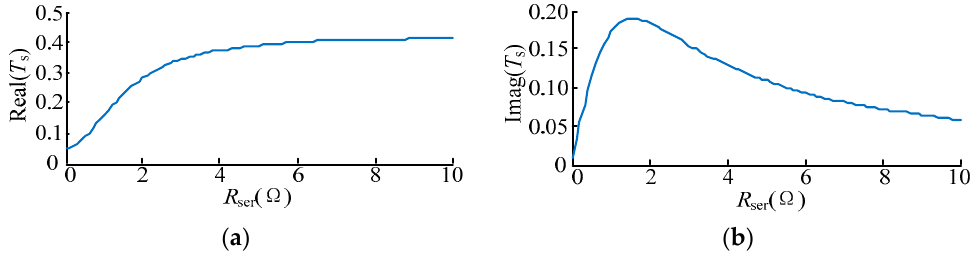
Figure 5. Equivalent circuit of the DFIG. ( a ) The real part of stator time constant; and ( b ) the imaginary part of stator time constant.